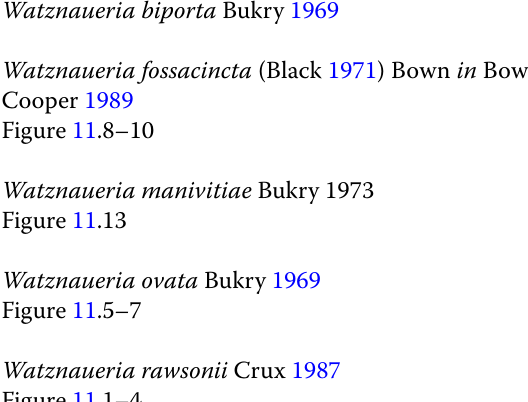
Discussion: W. rawsonii is a small (3.5–5 μm) species of Watznaueria with a normal width central area filled by a delicate and irregular grill. When preserved (Fig. 11.1), the grill is weakly birefringent. In sample LSBMRu1, W. rawso­ nii is relatively common, but much less than W. barnesiae , W. fossacincta and W. ovata . LO of W. rawsonii is placed by Crux (1989) in the Late Hauterivian Variabilis Zone in the Northern Germany basin. HO of W. rawsonii is not yet well constrained, but is present in the Late Barremian Sartousi- ana Zone (sample ECMRu10 from the Eclépens quarry).